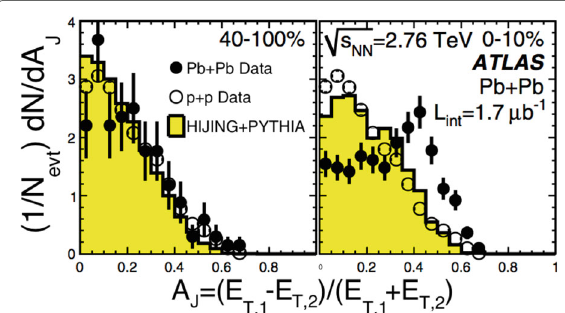
Fig. 5 Dijet asymmetry A J in the transverse energy for most central (right) and peripheral (left) events in Pb+Pb collisions as well as in √ s NN = 2.76 TeV from the ATLAS experiment [25], p+p collisions at compared with HIJING+PYTHIA √ s NN =